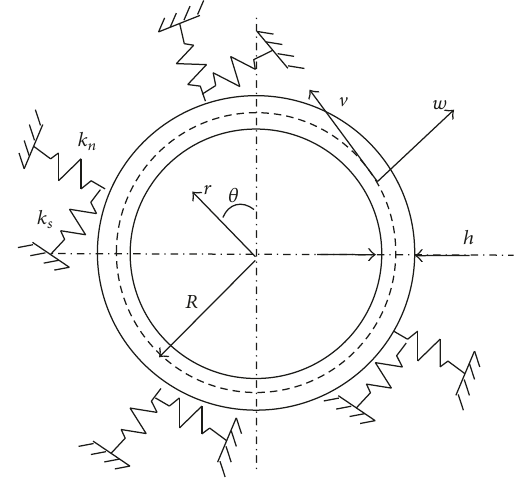
Figure 2: The schematic of a circular cylindrical shell.